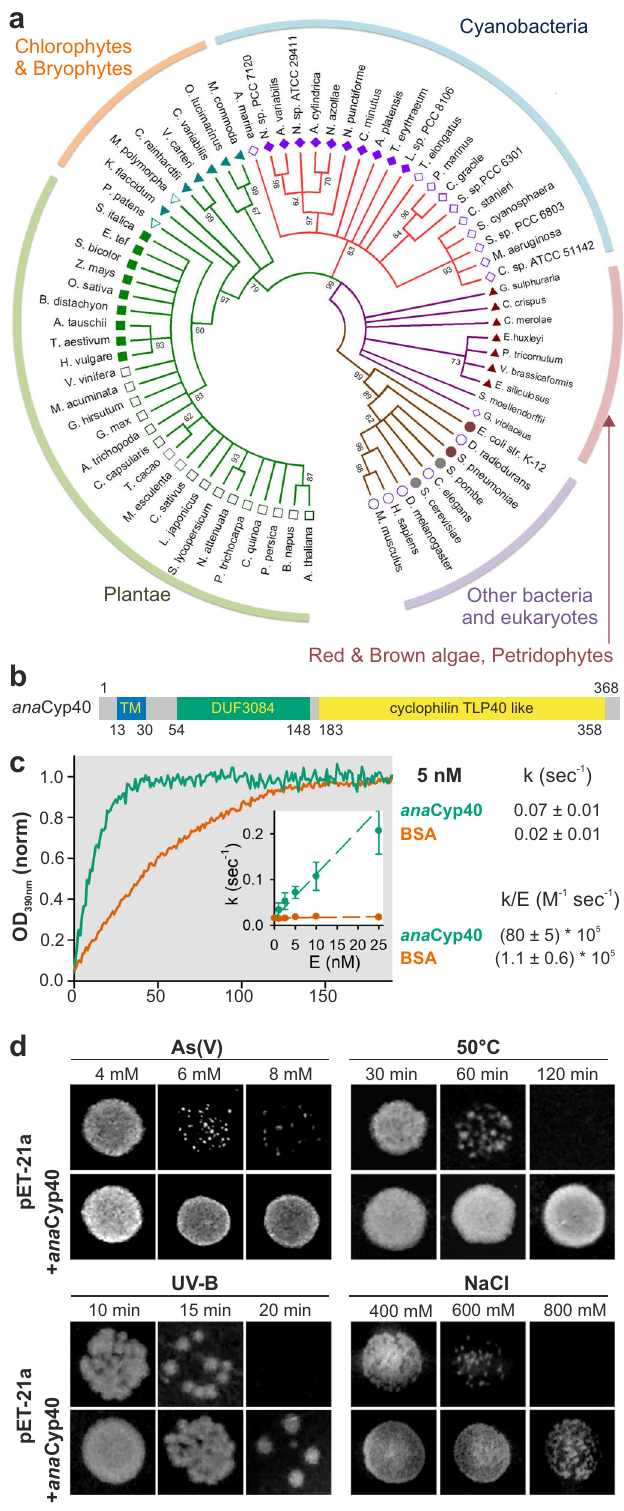
Fig. 1 The protein encoded by alr5059 shows a sequence similarity to at Cyp38. a Shown is the phylogenetic analysis of the sequences of the plant and cyanobacterial cyclophilin family as described in Materials and Methods (Supplementary Table 1). b The predicted domains of ana Cyp40 are shown as bar diagram. The conserved domains were extracted from NCBI database (CDD) 91 and additional regions for membrane anchoring or targeting predicted as described (Supplementary Table 2). TM: